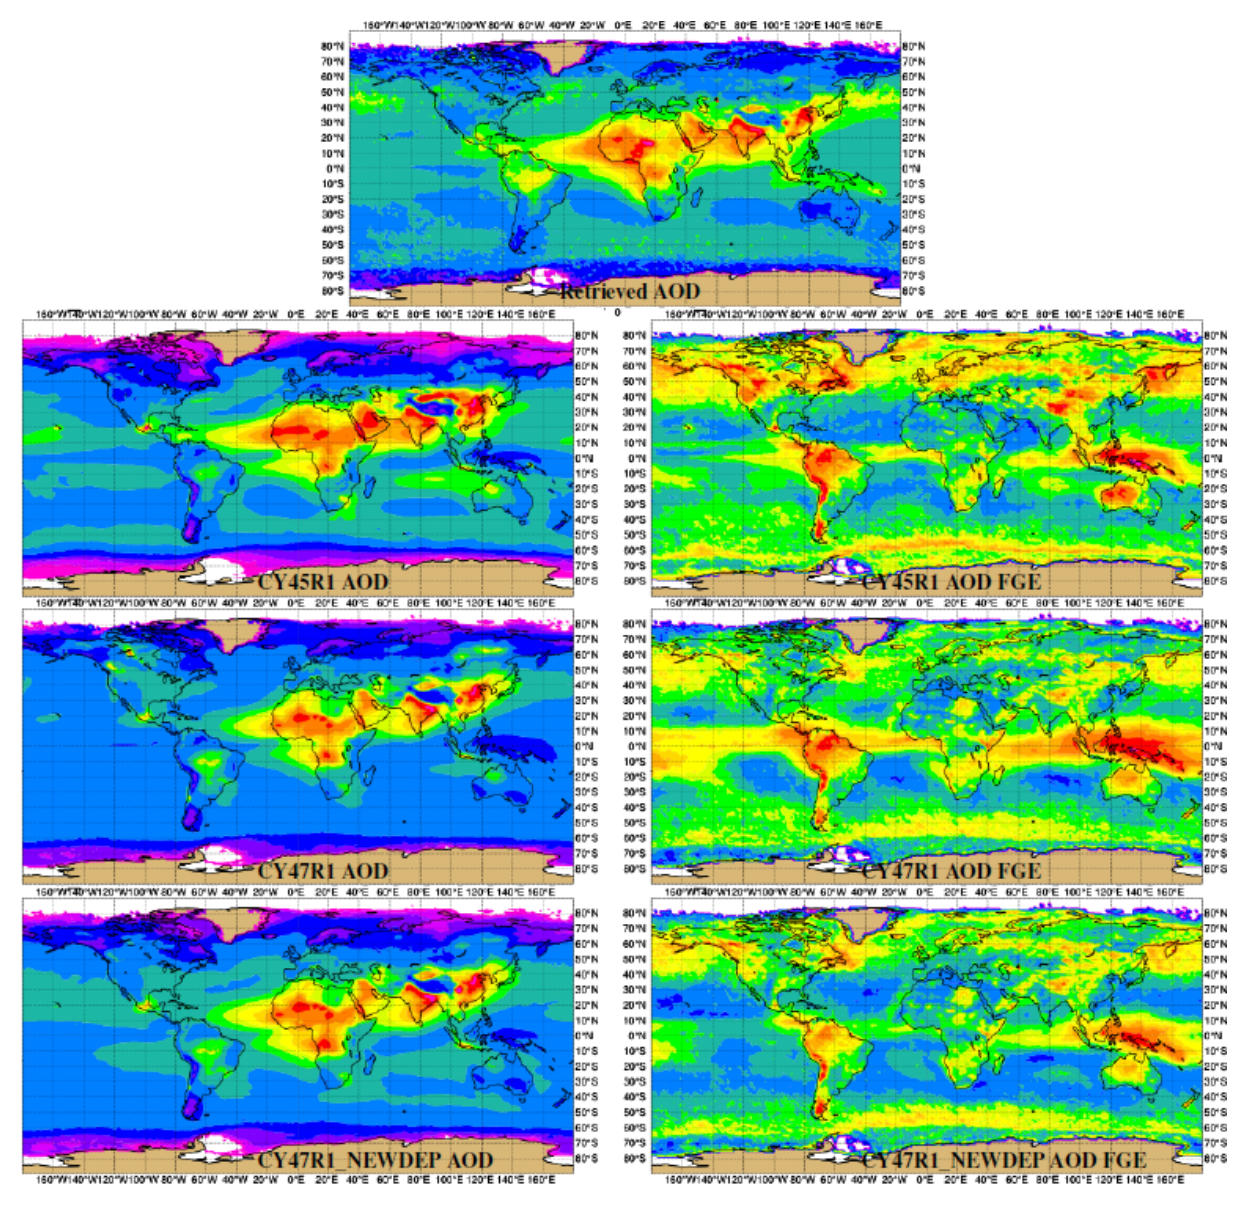
Figure 7. The top panel shows the 2017 average of merged AOD at 550nm from Sogacheva et al. (2020). The left column shows the co- located simulated yearly AOD for CY45R1, CY47R1 and CY47R1_NEWDEP from top to bottom. The right column shows the fractional gross error of simulated AOD against the merged AOD product for CY45R1, CY47R1 and CY47R1_NEWDEP from top to